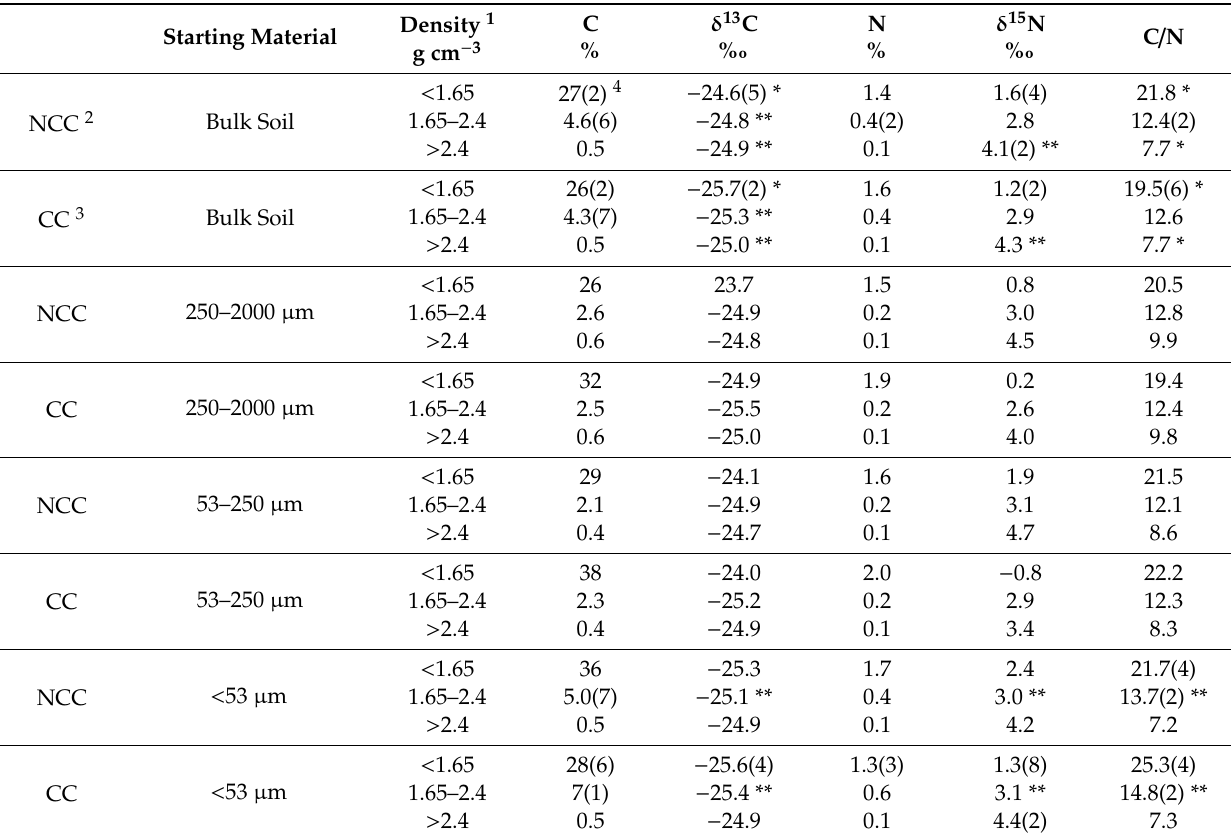
Table 2. Mass distribution, carbon and nitrogen abundance, and isotopic composition of sequential size-density separated aggregates from 0 to 10 cm depth of cover crop and no cover crop soils. Starting